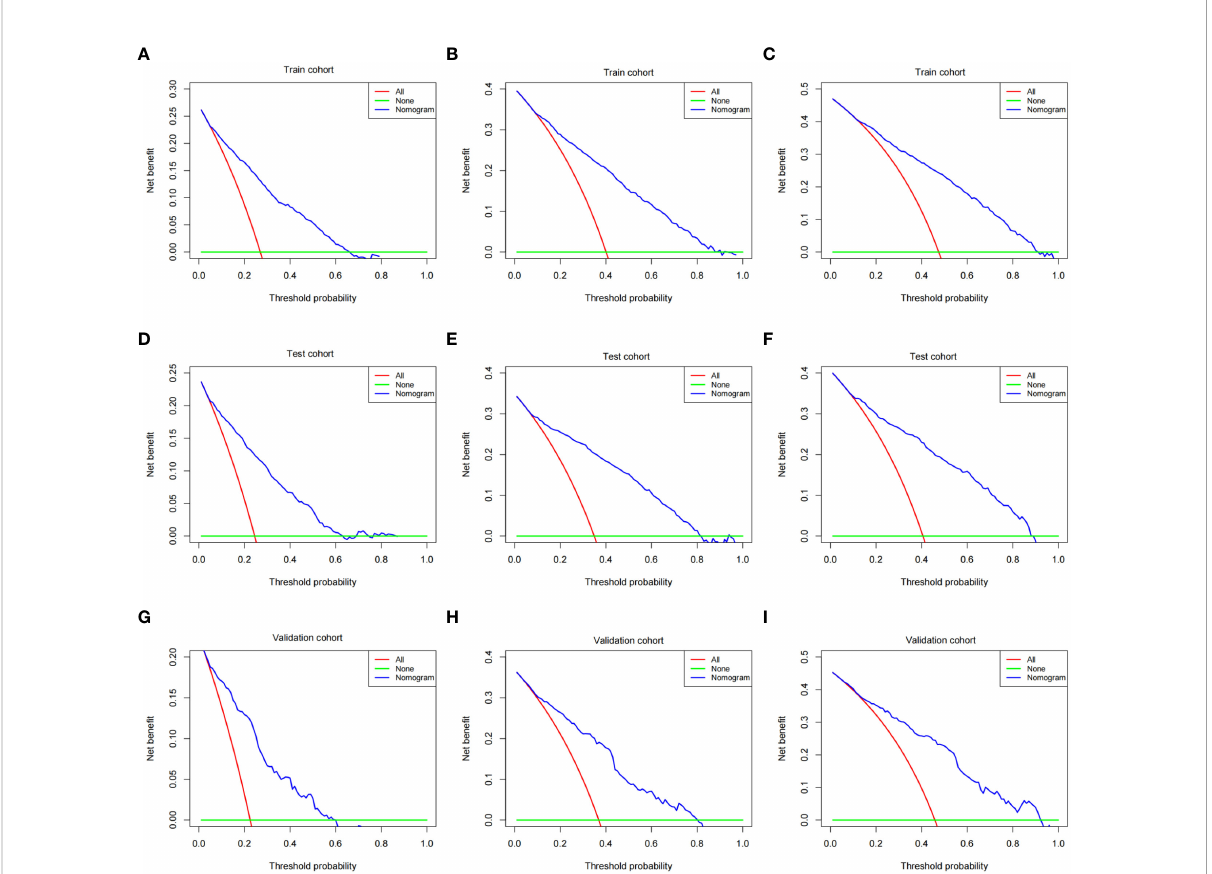
FIGURE 6 DCA of the OS nomogram. (A) 1-year DCA of the OS nomogram using train cohort. (B) 3-year DCA of the OS nomogram using train cohort. (C) 5-year DCA of the OS nomogram using train cohort. (D) 1-year DCA of the OS nomogram using the test cohort. (E) 3-year DCA of the OS nomogram using the test cohort. (F) 5-year DCA of the OS nomogram using the test cohort. (G) 1-year DCA of the OS nomogram using the validation cohort. (H) 3-year DCA of the OS nomogram using the validation cohort. (I) 5-year DCA of the OS nomogram using the validation cohort. DCA, decision curve analysis; OS, overall